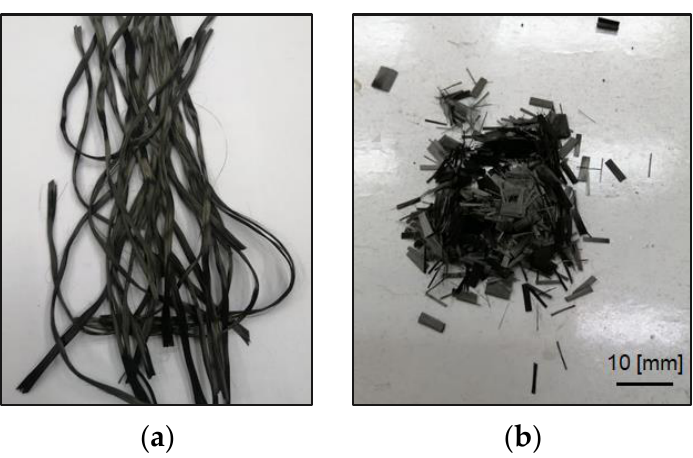
Figure 3. Carbon fiber: ( a ) in continuous form; ( b ) cut into 5 mm lengths. 4, 10 mm × 15 mm mesh; one or two layers of reinforcement in geopolymer.